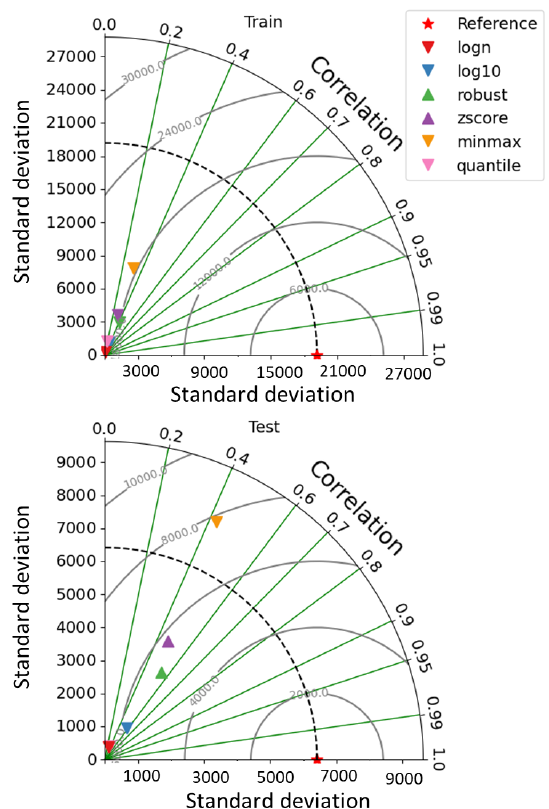
Figure 5. Comparison of different transformations of output data on the performance of a neural network in the simulation of in-stream E. coli concentrations (most probable number, MPN, 100mL) in a watershed in the Lao People’s Democratic